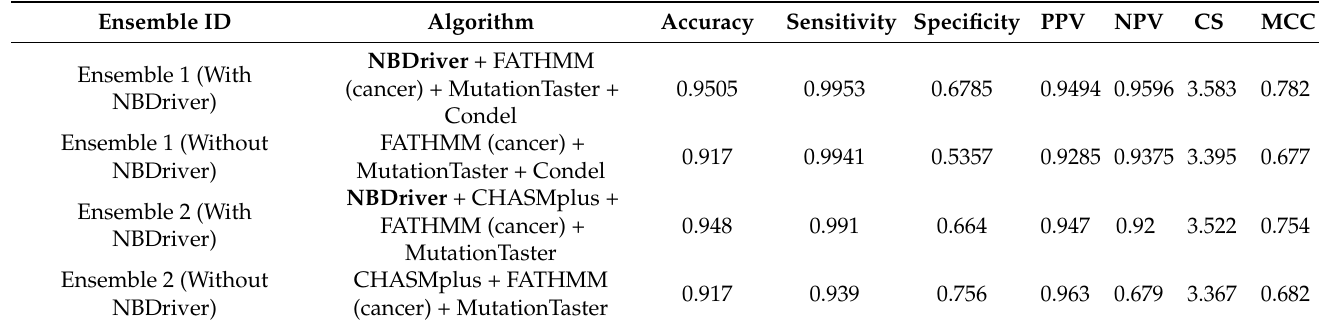
Table 3. Evaluating the contribution of NBDriver to the top-performing ensemble